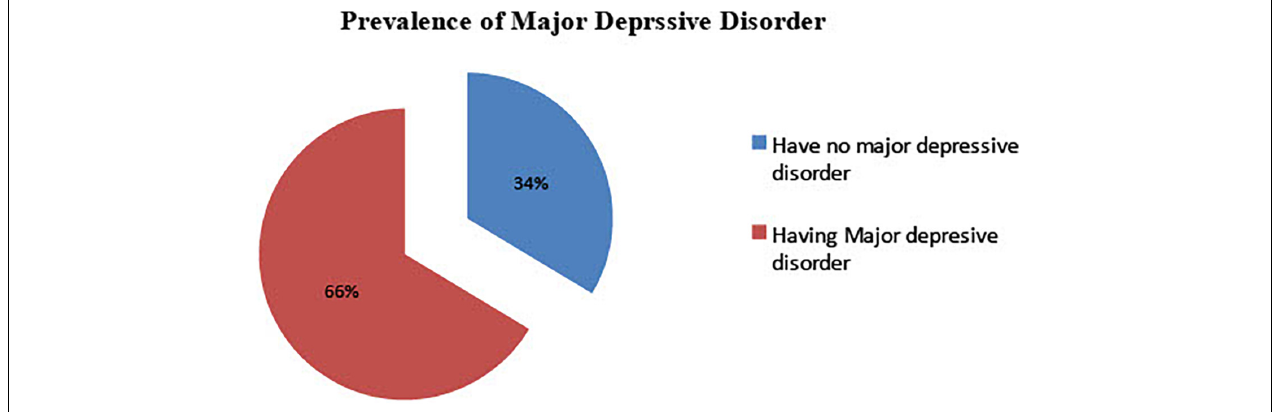
FIGURE 1 | Major depressive disorder during COVID-19 pandemic, among Dessie town prisoners, in Dessie Amhara region, Northeast Ethiopia, October 2020; ( n = 420).